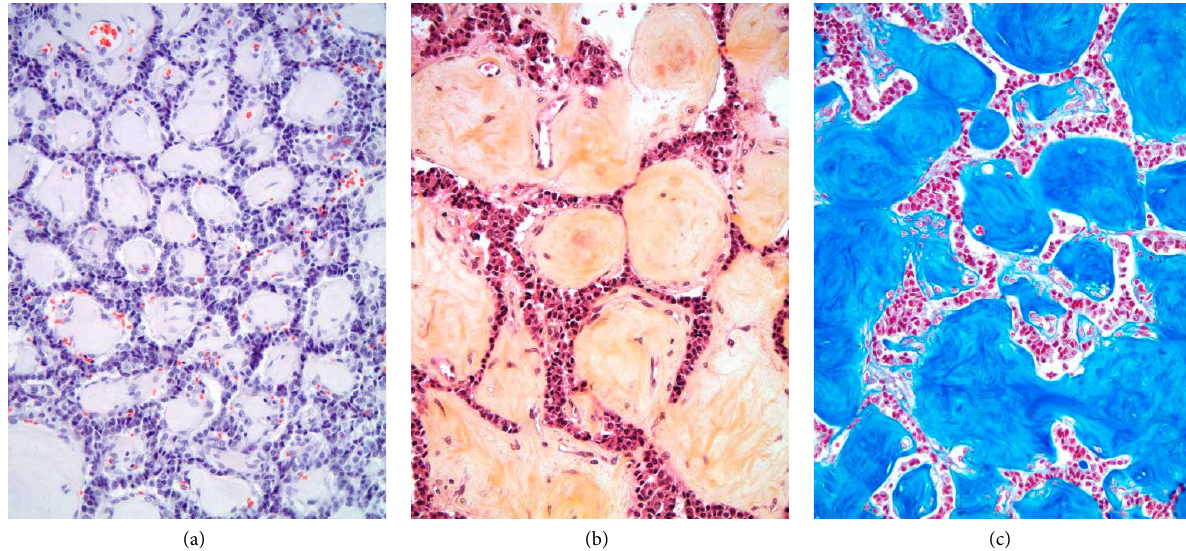
Figure 10: (a) Absence of brick red staining and no evidence of apple-green birefringence on polarized light excludes amyloid protein deposition in the cobblestones (Congo red stain, 200X). (b) Orange-pink staining with intrinsic fibrils in sections of the cobblestones supports the impression of spheroids of fibrous tissue (Movat stain, 200X). (c) Azure blue staining with intrinsic fibrils further indicates that the homogenous and paucicellular spheroids are comprised of fibrous tissue (Trichrome stain,